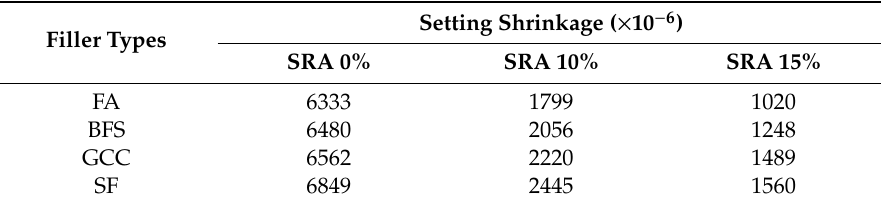
Table 8. Setting shrinkage with SRA contents and filler